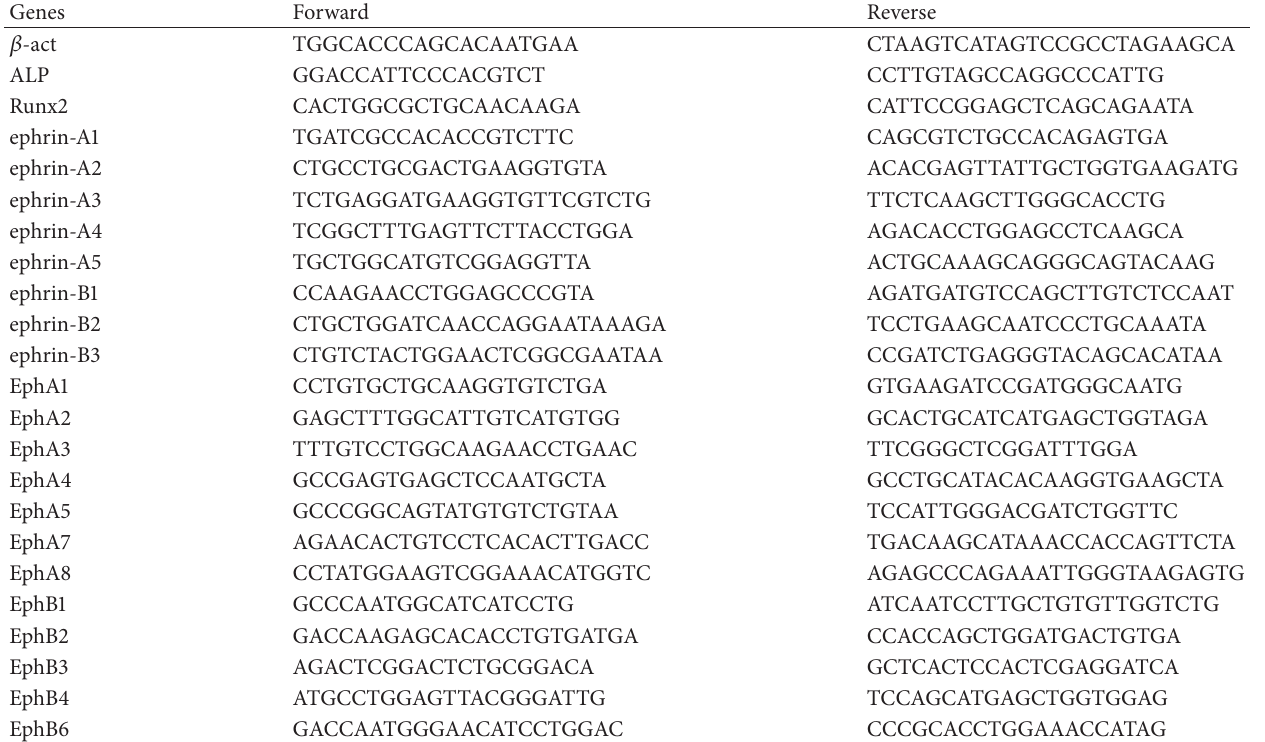
Table 1: RT-PCR primers used in this